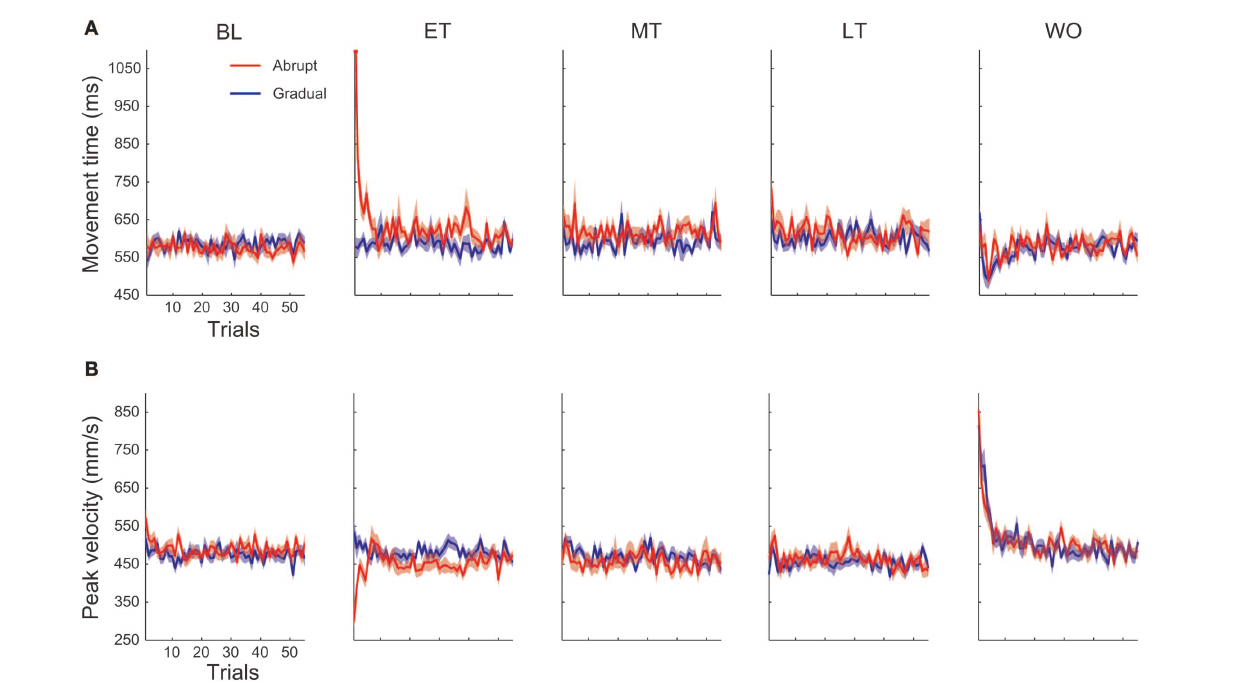
FIGURE 6 | Trial-by-trial changes in movement time (A) and peak velocity (B) from the baseline block (BL), early training block (ET), middle training block (MT), late training block (LT), and the